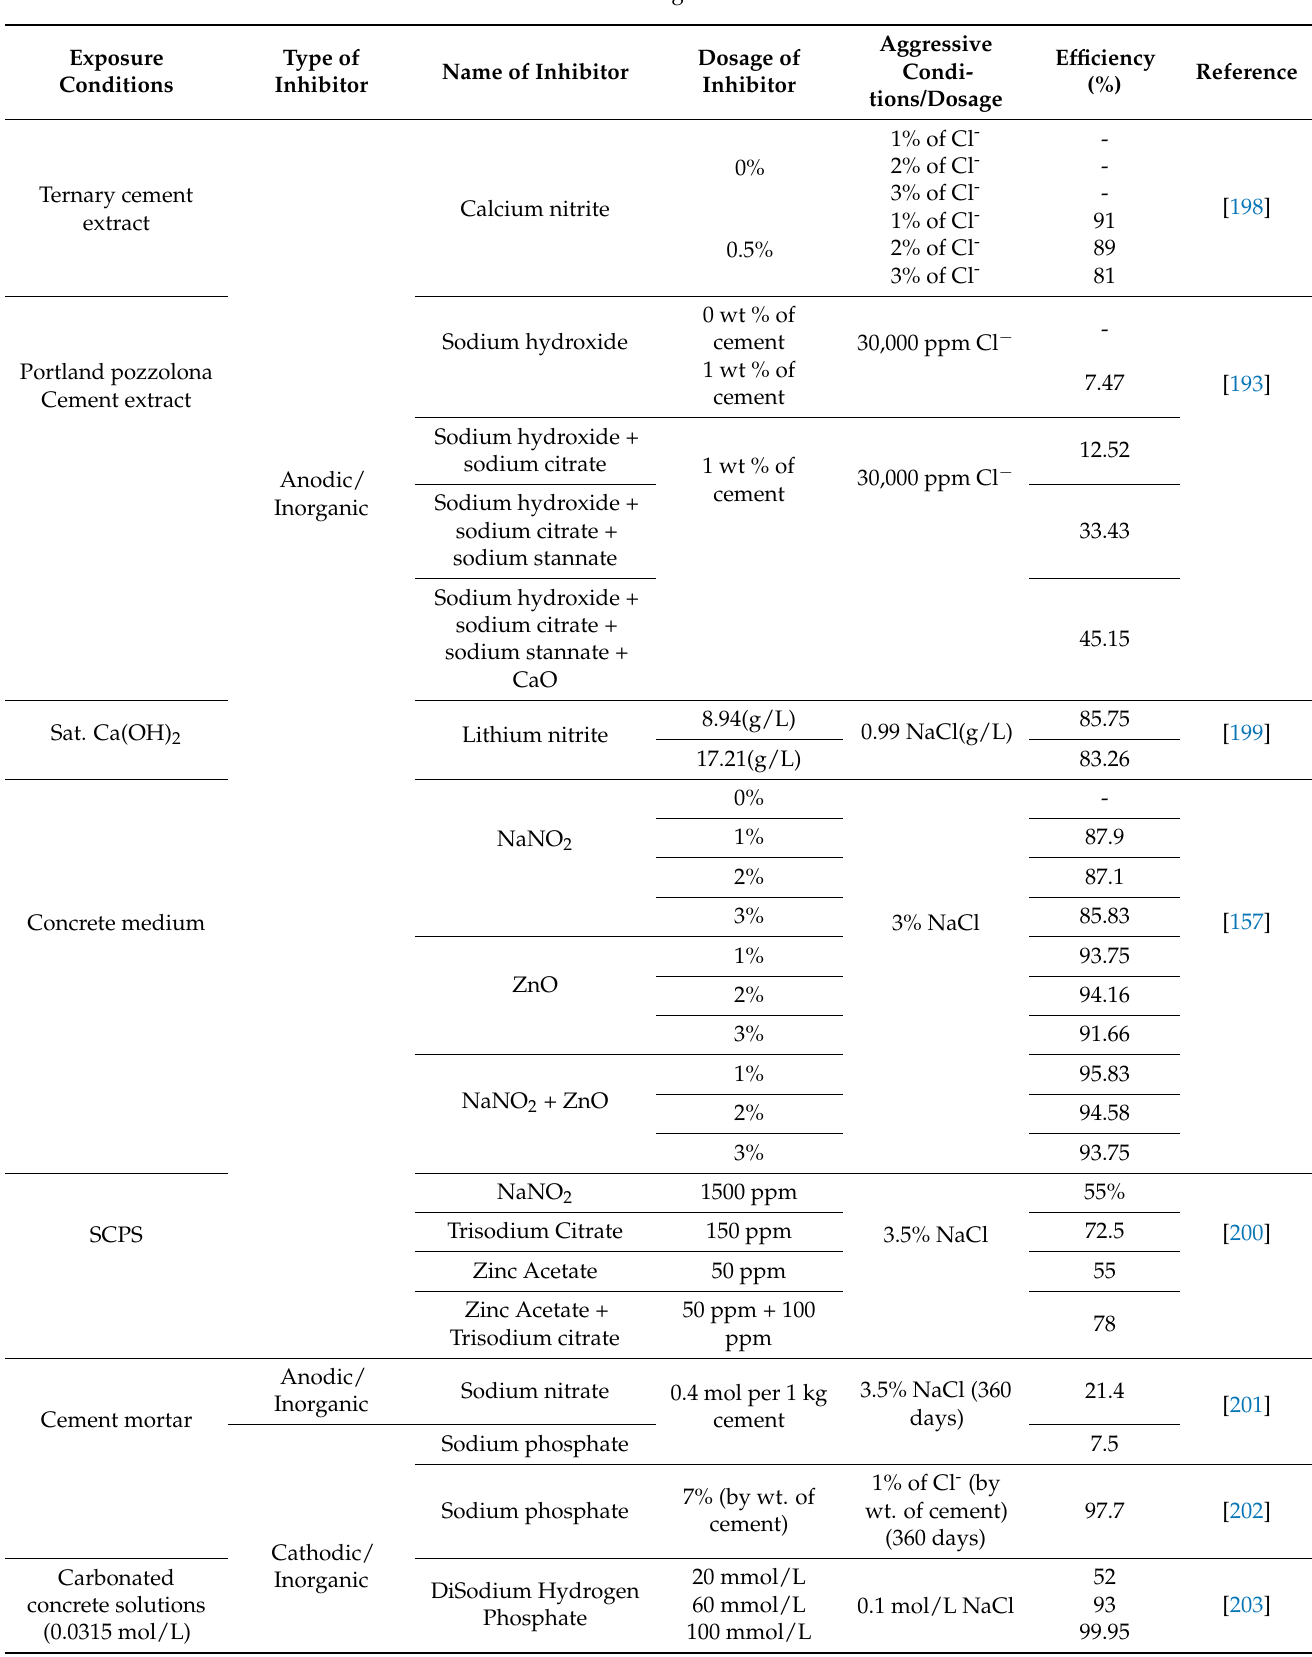
Table 7. Corrosion inhibiting admixtures in